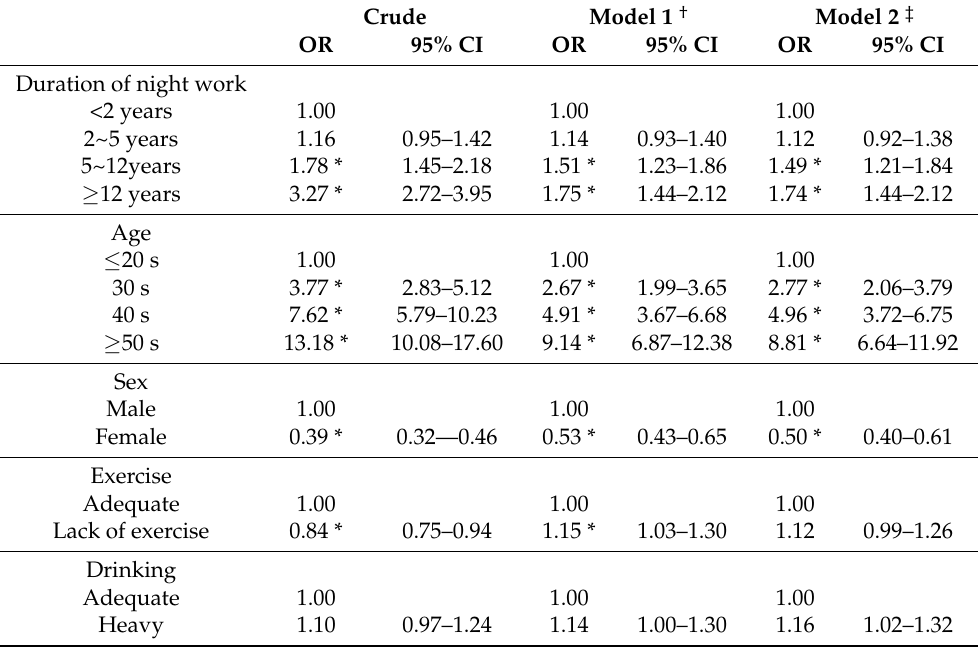
Table 2. Associations between the general characteristics of the participants and